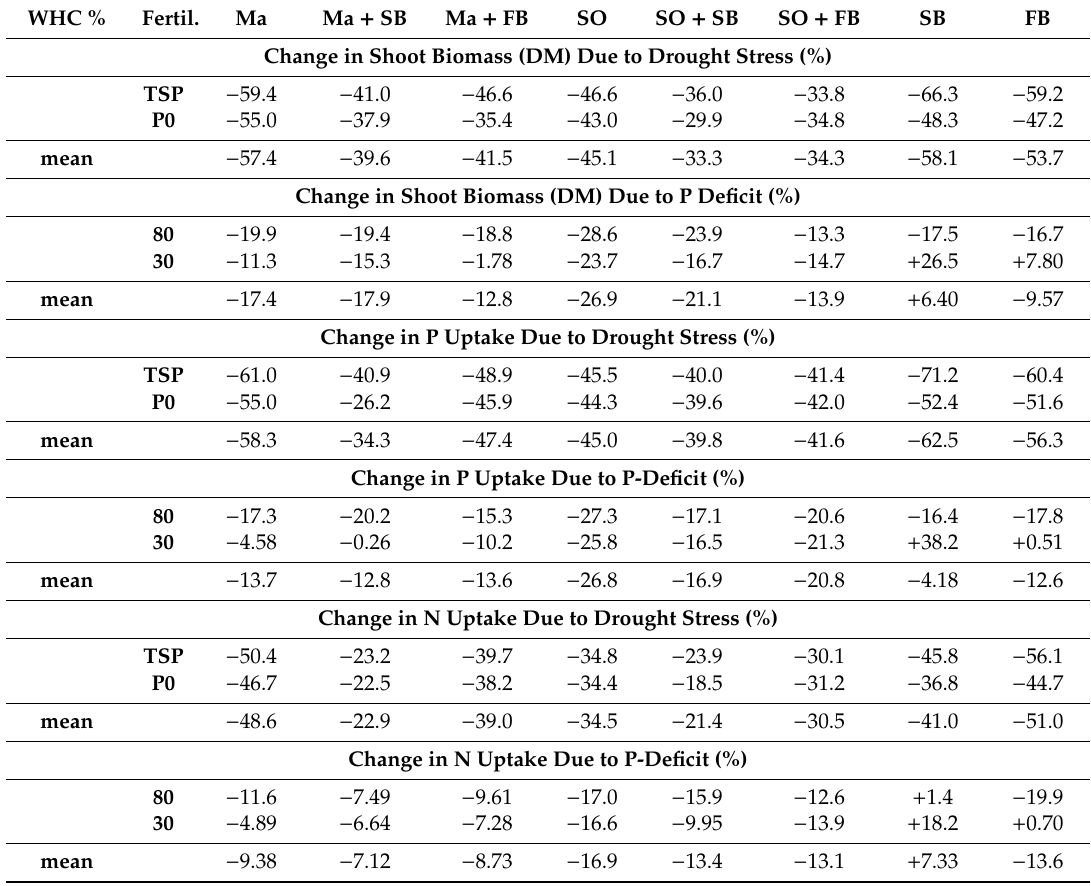
Table A4. Reduction of yield and nutrient uptake in consequence of drought and P deficit in the